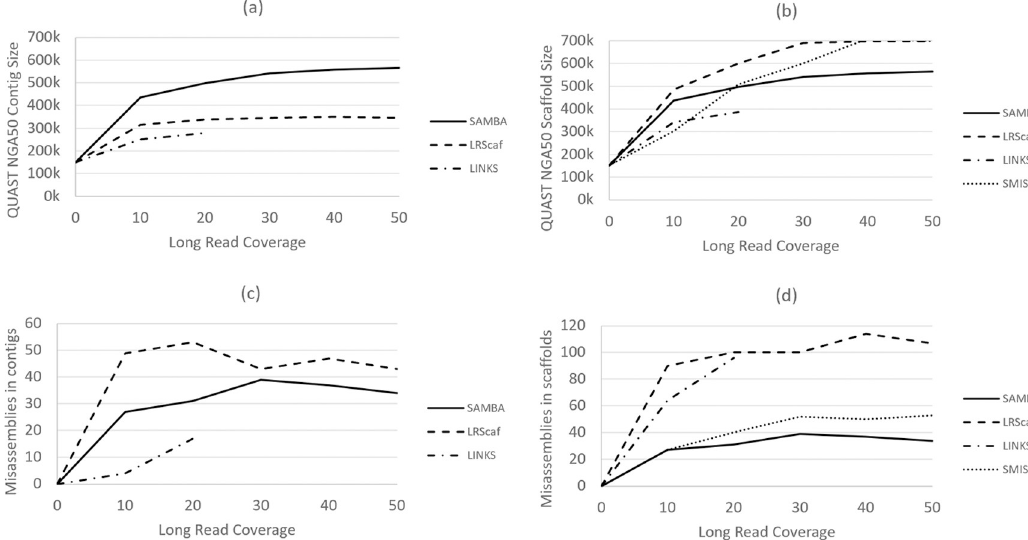
Fig 1. Scaffolding the Athal-Illumina assembly with LINKS, SMIS, LRScaf, and SAMBA. We compared performance as a function of long-read (PacBio) coverage, shown on the x-axis. Panels (a) and (b) show the NGA50 size for contigs and scaffolds after scaffolding with each tool. SAMBA outputs contigs, and thus its scaffold and contig results are the same. Panels (c) and (d) show the number of mis-assemblies introduced by the scaffolding process. The LINKS scaffolder required more than 512GB of RAM for PacBio coverage > 20x, and thus we did not run it with higher coverage. SMIS does not change contigs, so we did not include its statistics on panels (a) and (c).